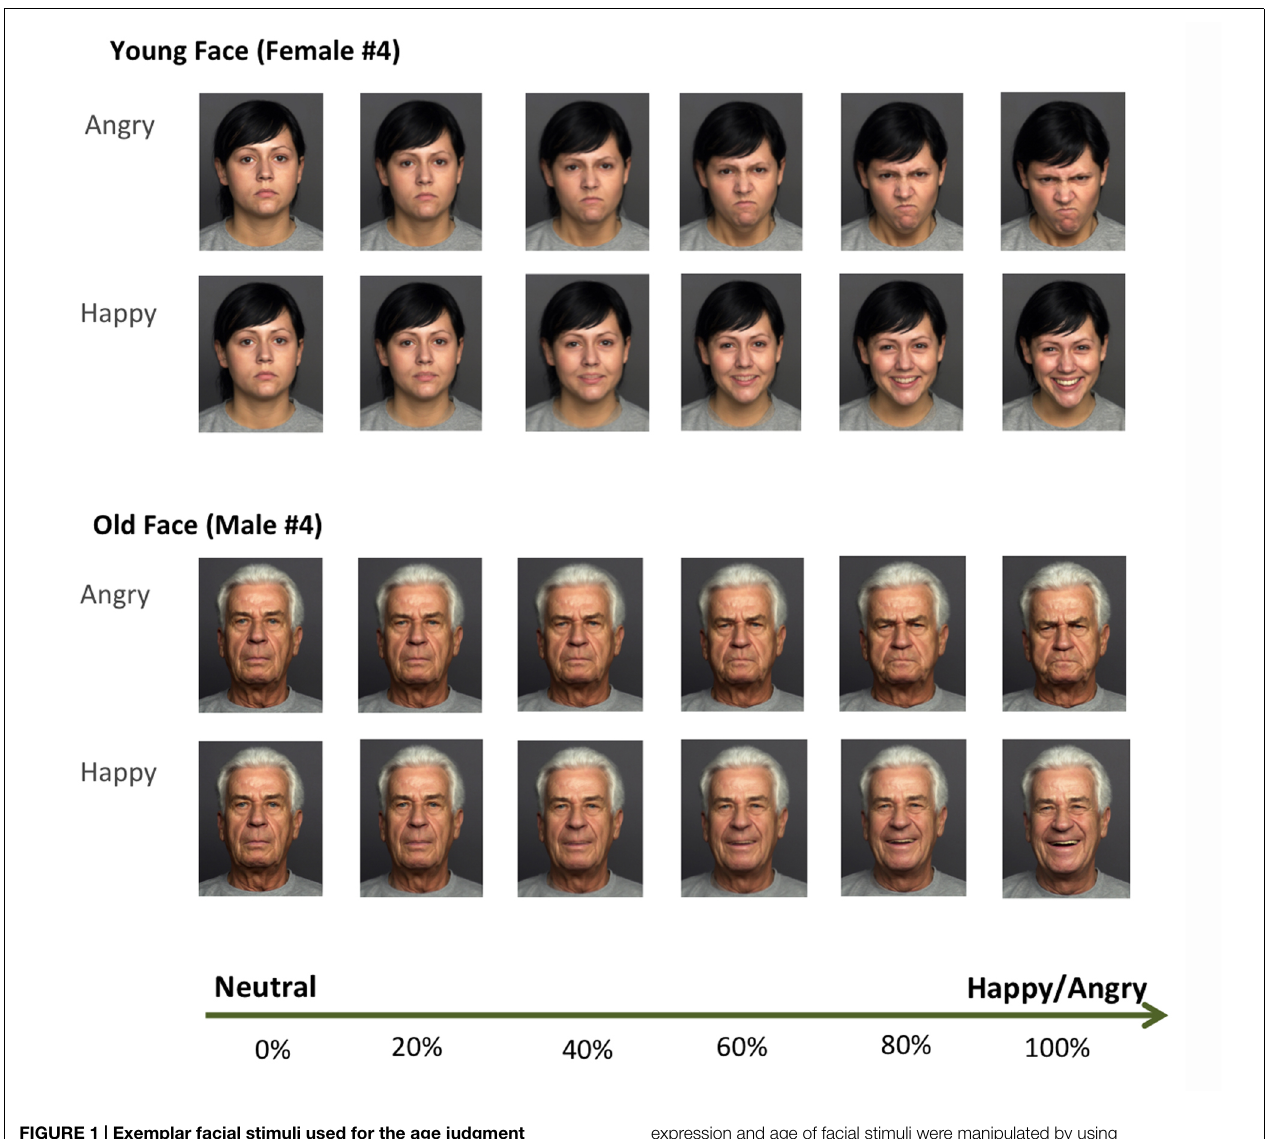
FIGURE 1 | Exemplar facial stimuli used for the age judgment task. Total eight identities (two young and two old male identities, and two young and two old female identities; only two identities are shown here for examples) were used in the main experiment. Emotional